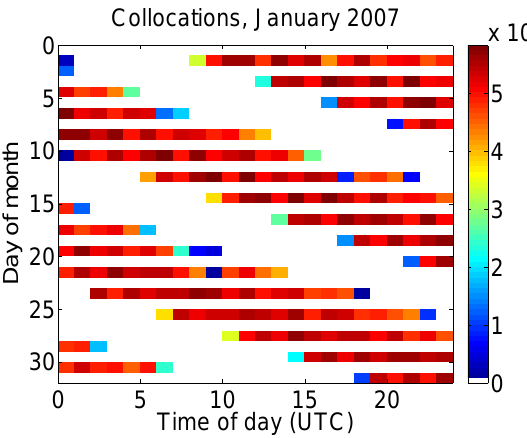
Fig. 5. Number of collocations per hour in January 2007. The vertical axis shows the day of the month. The horizontal axis shows the universal time.